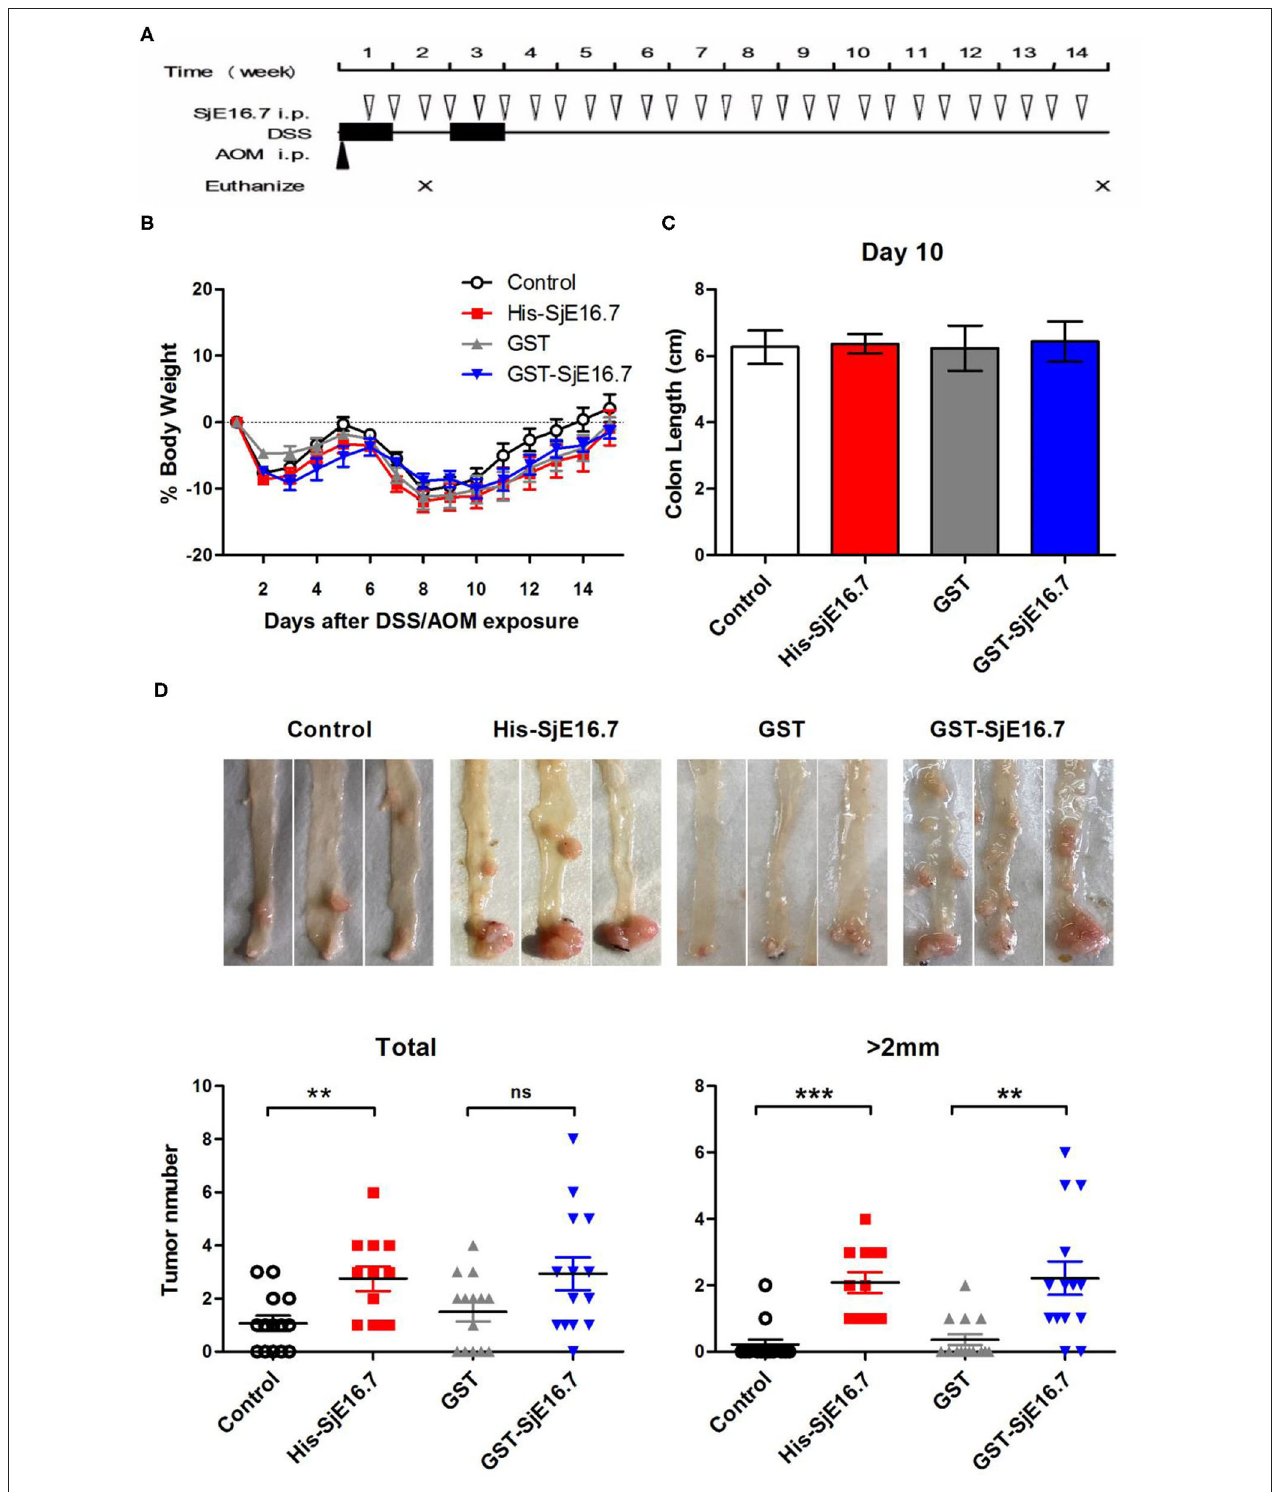
FIGURE 5 | SjE16.7 promotes colon-rectal cancer development in mice. (A) Illustration of the experimental layout of CAC induction and in vivo treatment with recombinant protein His-SjE16.7, GST-SjE16.7, and GST control. (B) Change in body weight over time is expressed as the percentage of the initial body weight. Pooled data from four independent experiments is shown. n = 15–20 per group. (C) Colon length was measured on day 10, n = 5 per group. (D) Colonic neoplasms were photographed and numbers of macroscopic neoplasms were counted individually at week 14. Results are presented as pooled data from three independent experiments. ** p < 0.01, *** p < 0.001 compared with the indicated control group.